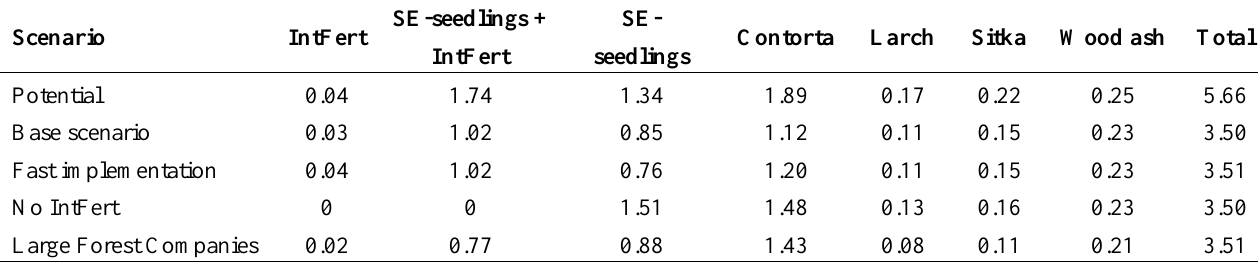
Table 4. Potential areas (million hectares) for each IFM treatment, and distribution of the area among the IFM treatments under the four